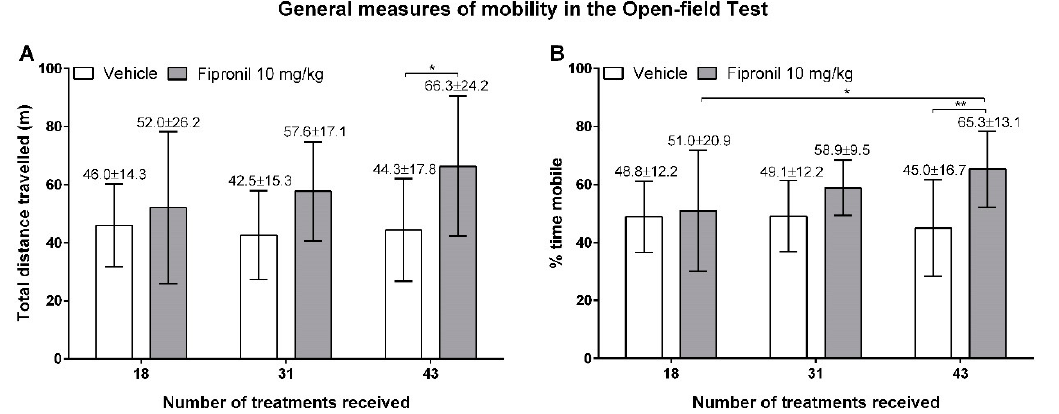
Figure 2. Measures of open-field activity during the 30 min of free exploration during the three sessions of open-field testing. Mean values ± SD are indicated above the corresponding bars. ( A ) Total distance (in meters) travelled by the animals (Y axis) as a function of the number of treatments (X axis). Treatment type had a modest but significant influence on the total distance travelled. ( B ) Relative mobility time of animals during the 30 min of free exploration in the percentage of the total trial duration (Y axis), as a function of the number of treatments (X axis). Treatment type had a significant e ff ect on the relative mobility time. *: p ≤ 0.05; **: p ≤